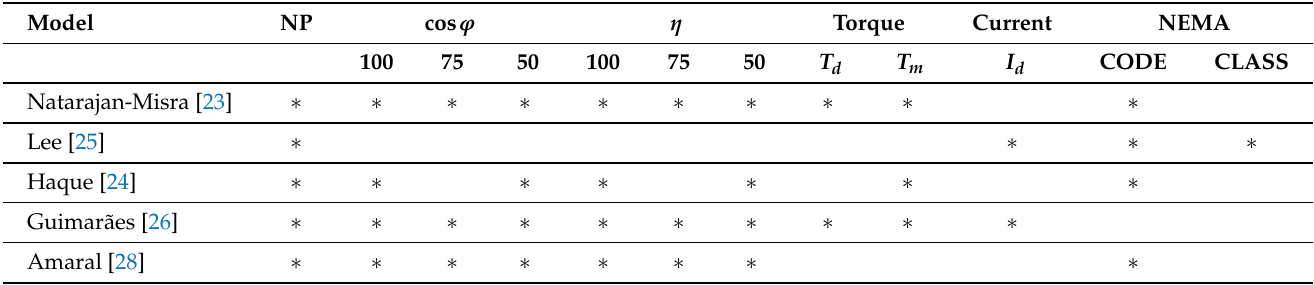
Table 1. Data needed for the different